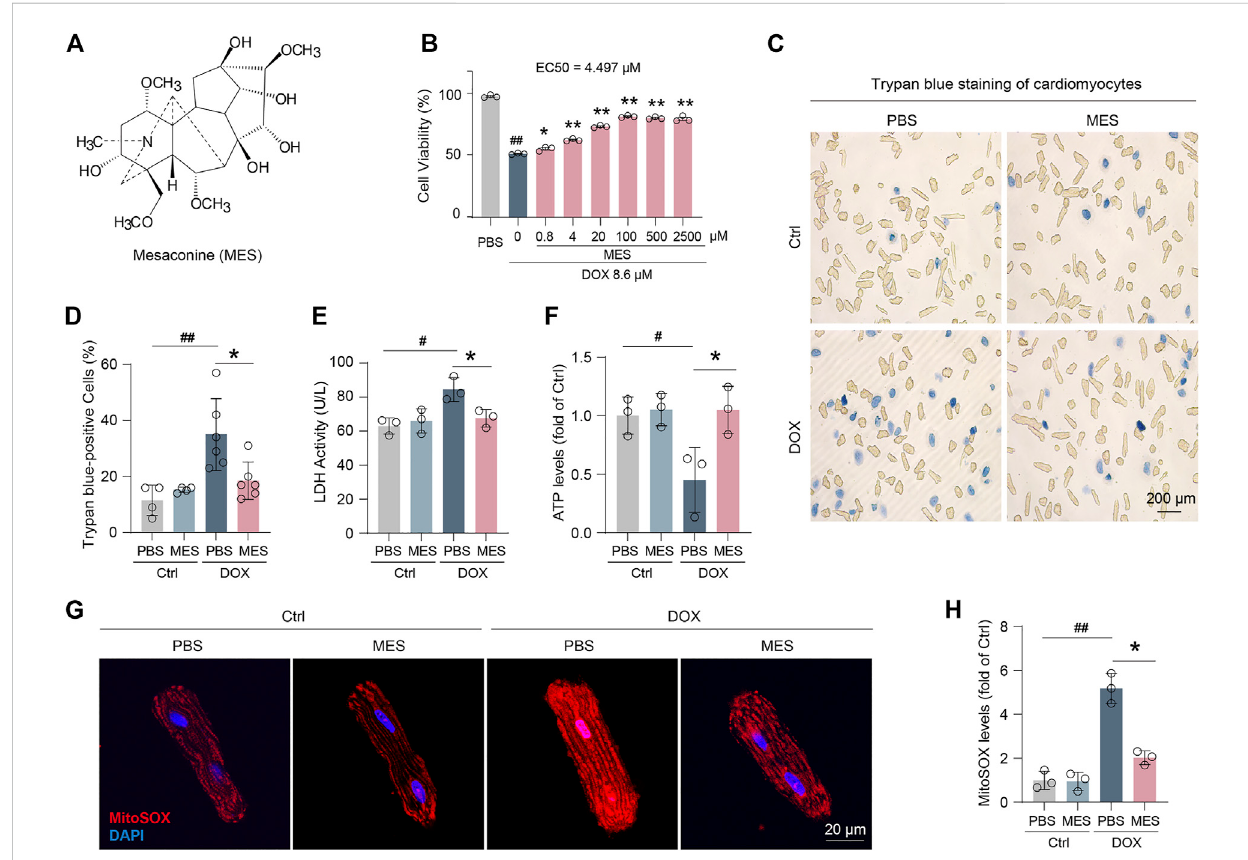
FIGURE 1 Mesaconine attenuated DOX-induced cardiomyocytes injury. (A) Chemical structure of mesaconine. (B) The cell viability of DOX and/or mesaconine-treated cardiomyocytes were detected by CCK-8 assay. (C) Representative images of cardiomyocytes stained with trypan blue (n = 5). (D) Quantitative analysis of trypan blue positive cardiomyocytes. (E, F) Treatment mesaconine showed resistance to DOX-induced LDH release (E) and reducedATPproduction (F) . (G) RepresentativeimagesofMitoSOX(mitochondrialROS)levelsweremeasuredbyimmuno fl uorescencestaining. (H) Quanti fi cation of MitoSOX levels. Data are represented as means ± SEM of at least 3 biologically independent replicates assays. *, # p < 0.05; **, ## p <